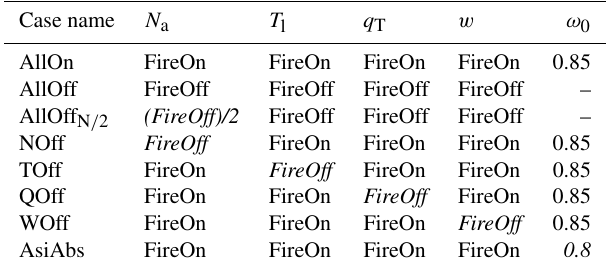
Table 2. Source (WRF-CAM5 FireOn or FireOff) of the variable in the forcing and value of the single-scatter albedo for each SAM case. The variable perturbed from the AllOn or AllOff case is itali-